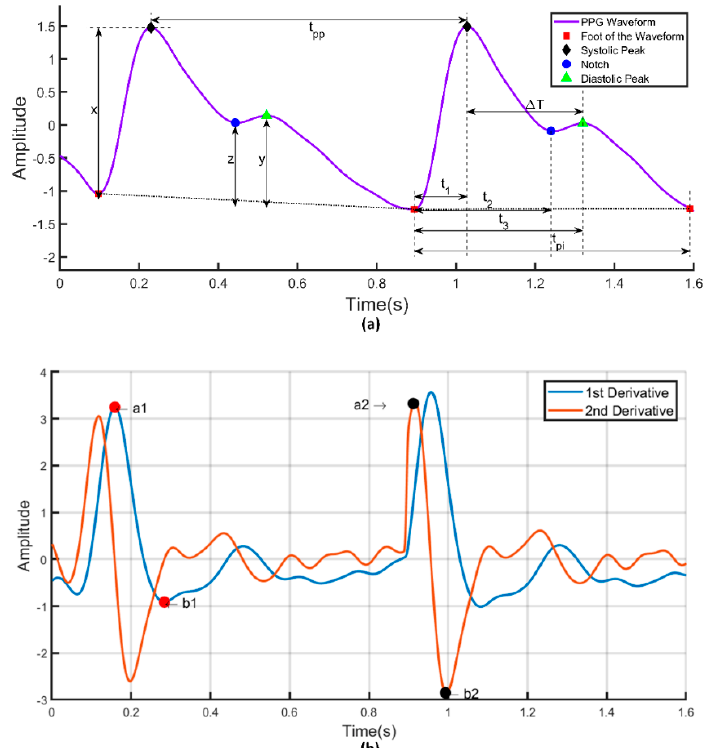
Figure 11. ( a ) Illustration of time-domain features in a PPG signal. ( b ) First and second derivatives of PPG signal.